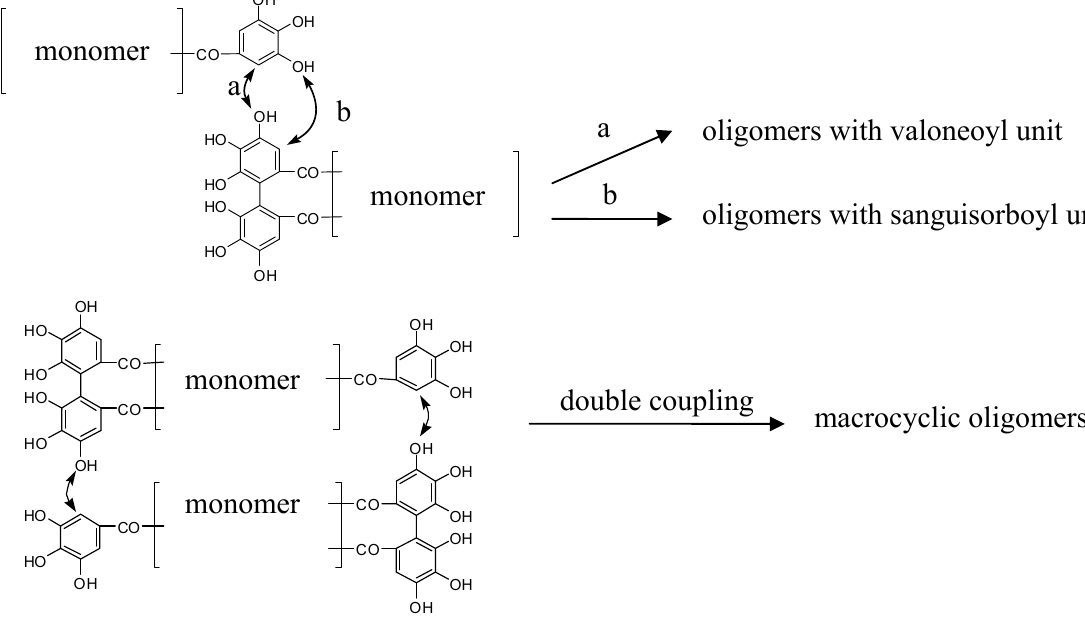
Figure 5. Structures of C-glycosidic ellagitannin dimers 45 – 48